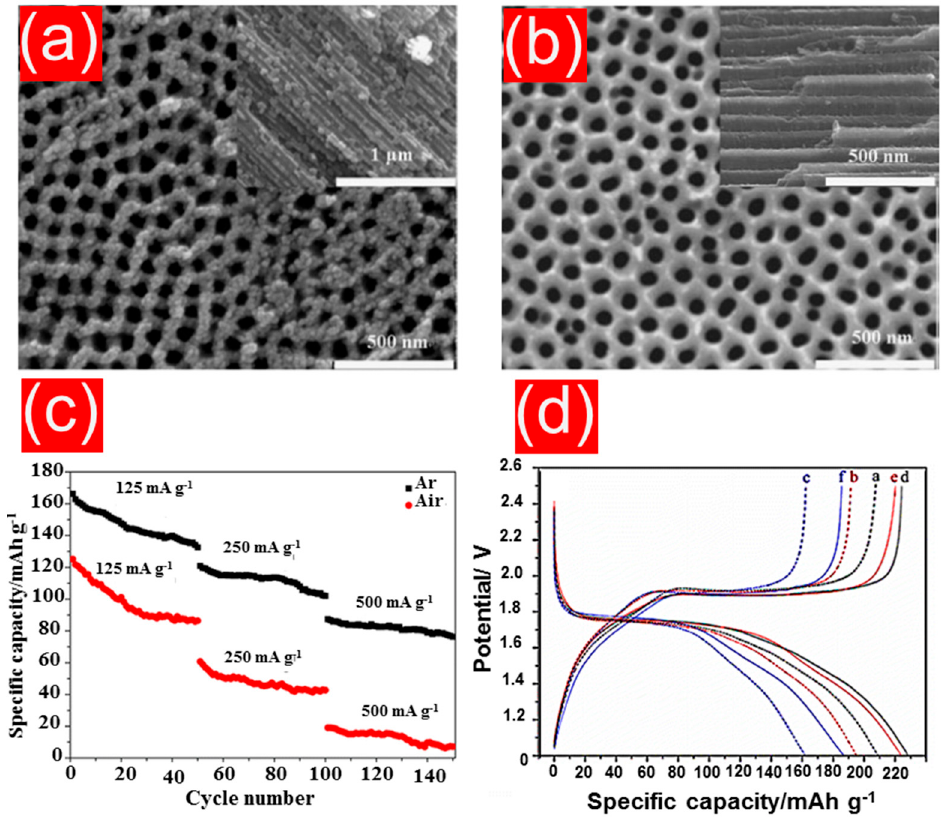
Figure 12. SEM micrographs of the TiO 2 nanotubes thermally treated in ( a ) Ar in ( b ) air atmosphere and ( c ) the rate capability of each electrode, ( d ) voltage profile curves of the first discharge cycle of TiO 2 membranes, a, b, c representing annealed at 450 °C, 600 °C, and 800 °C in air, with d, e, f being 450 °C, 600 °C, 800 °C in Ar, respectively. Adapted with permission from ref. [154].